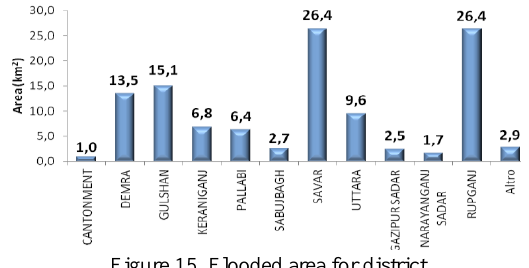
Figure 15. Flooded area for district.